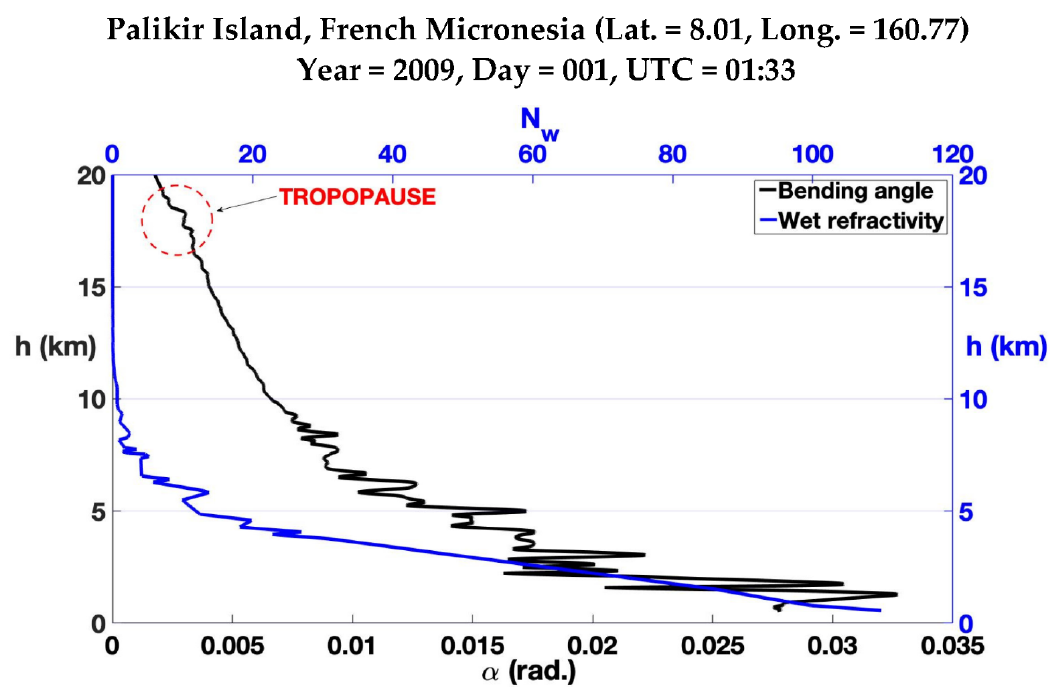
Figure 7. Bending angle (blue) and wet refractivity (black) profiles from an RO event colocated with a radiosonde atmospheric excursion. A slight irregular behavior for the bending angle at ~18 km is in correspondence with the tropopause altitude (red circle).